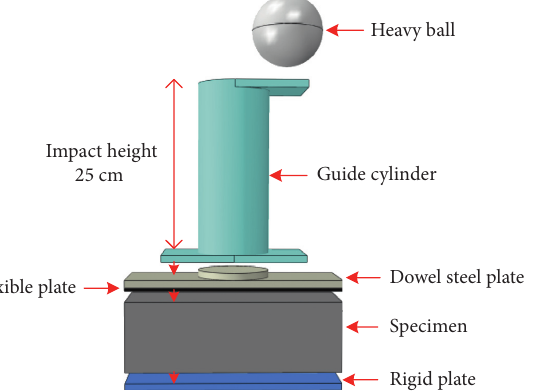
Figure 3: Drop-weight experiment equipment.